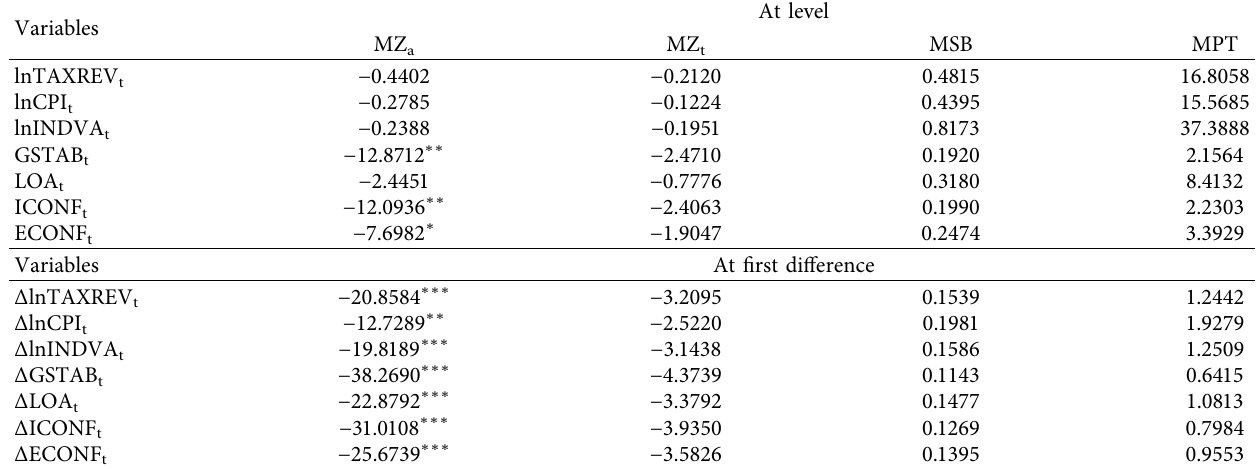
Table 4: Unit root test.